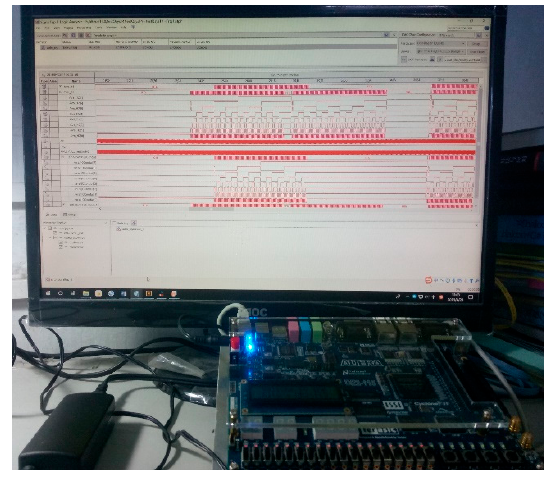
Figure 16. Experiment circuit board and Signaltap II diagram.